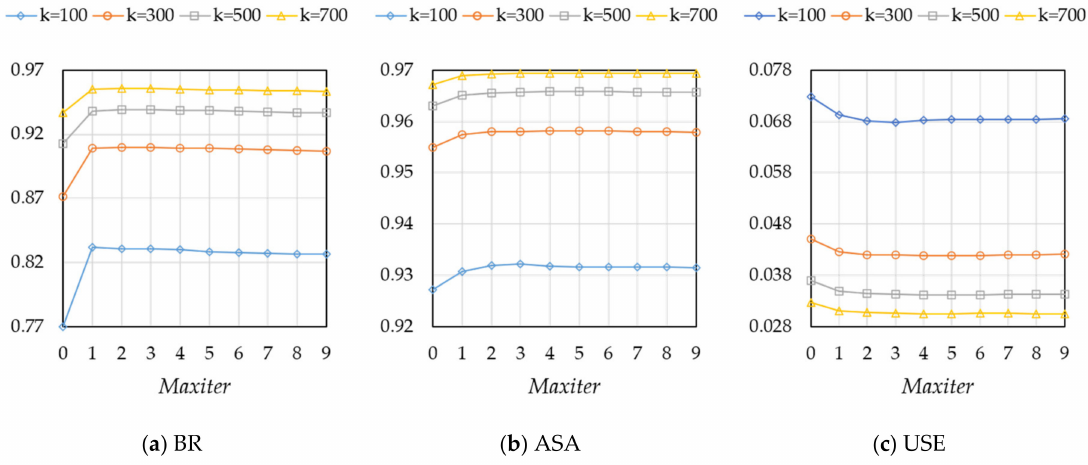
Figure 7. The performance metrics of our approach for di ff erent Maxiter